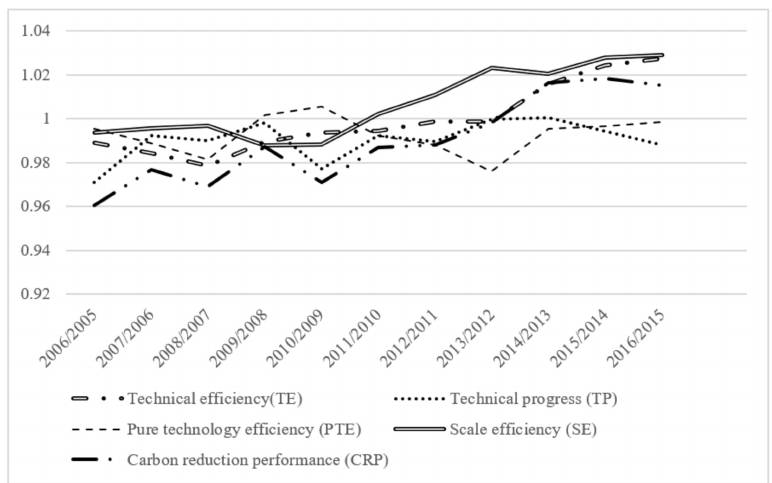
Figure 3. Carbon-reduction performance and contributors’